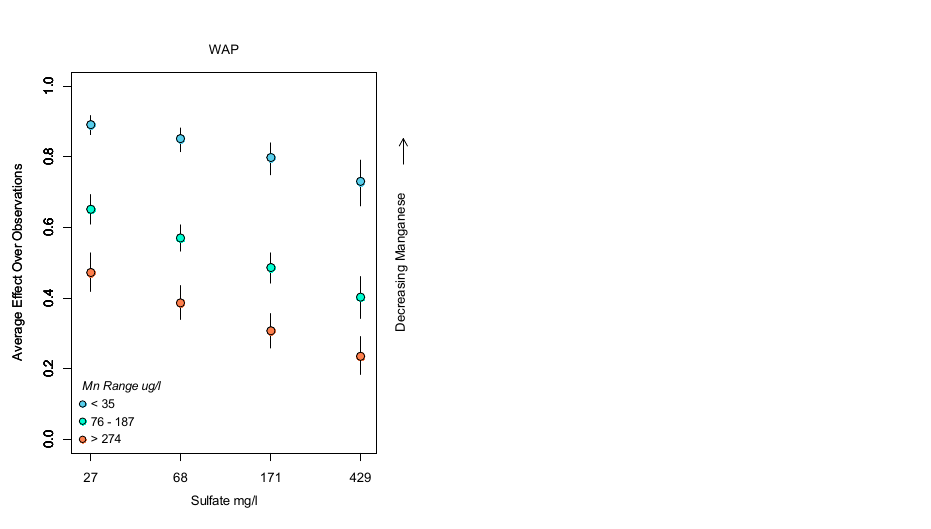
Figure 10. Probabilities of observing macroinvertebrate communities meeting the ecoregion benchmark for the Western Allegheny Plateau given four levels of sulfate and observations of covariates within three data slices defined by quantile levels of manganese (lower, middle and upper 25th quantiles). The sulfate levels were obtained by sequencing the range from the 25th to 90th percentiles (in log space).